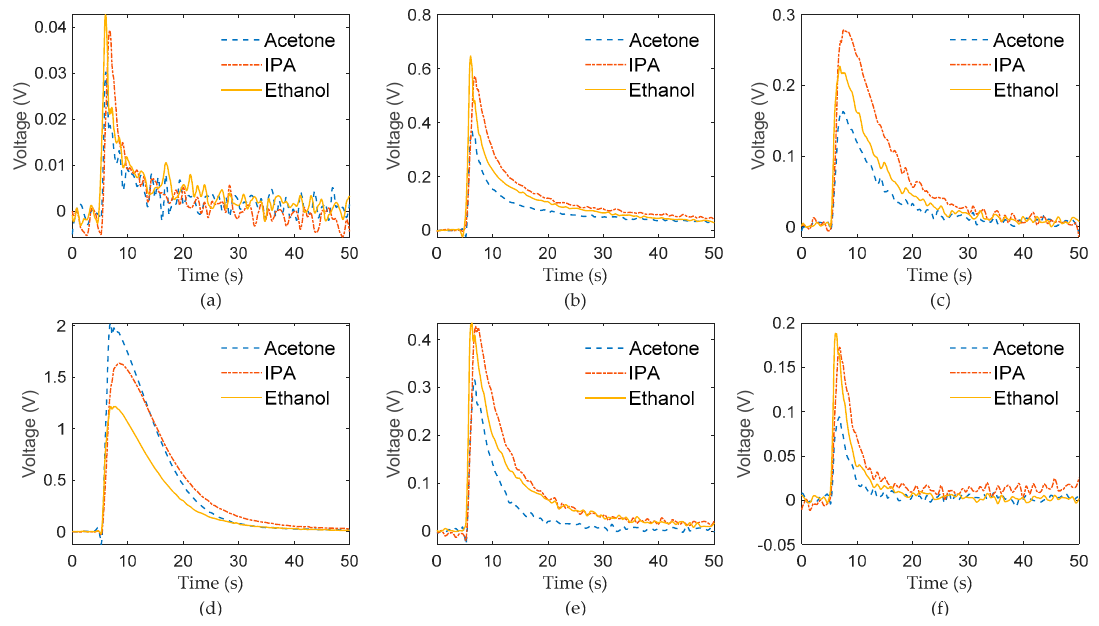
Figure 3. Response curves of ( a ) MQ 136, ( b ) MQ 136, ( c ) TGS 2600, ( d ) TGS 2602, ( e ) TGS 2610, ( f ) TGS 2611 to different VOCs: 2 mL of 8.3% acetone (in air); 10 mL of 1.71% IPA (in air); 10 mL of 1.74% ethanol (in air).